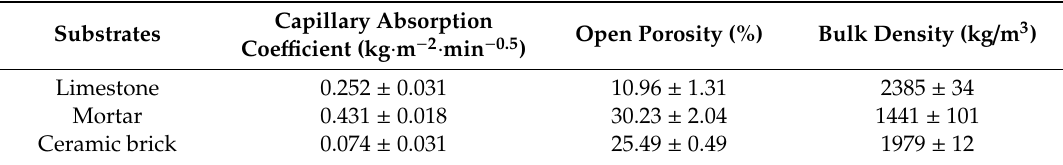
Table 1. Average results and standard deviation of capillary water absorption coe ffi cient, open porosity and bulk density of the substrates